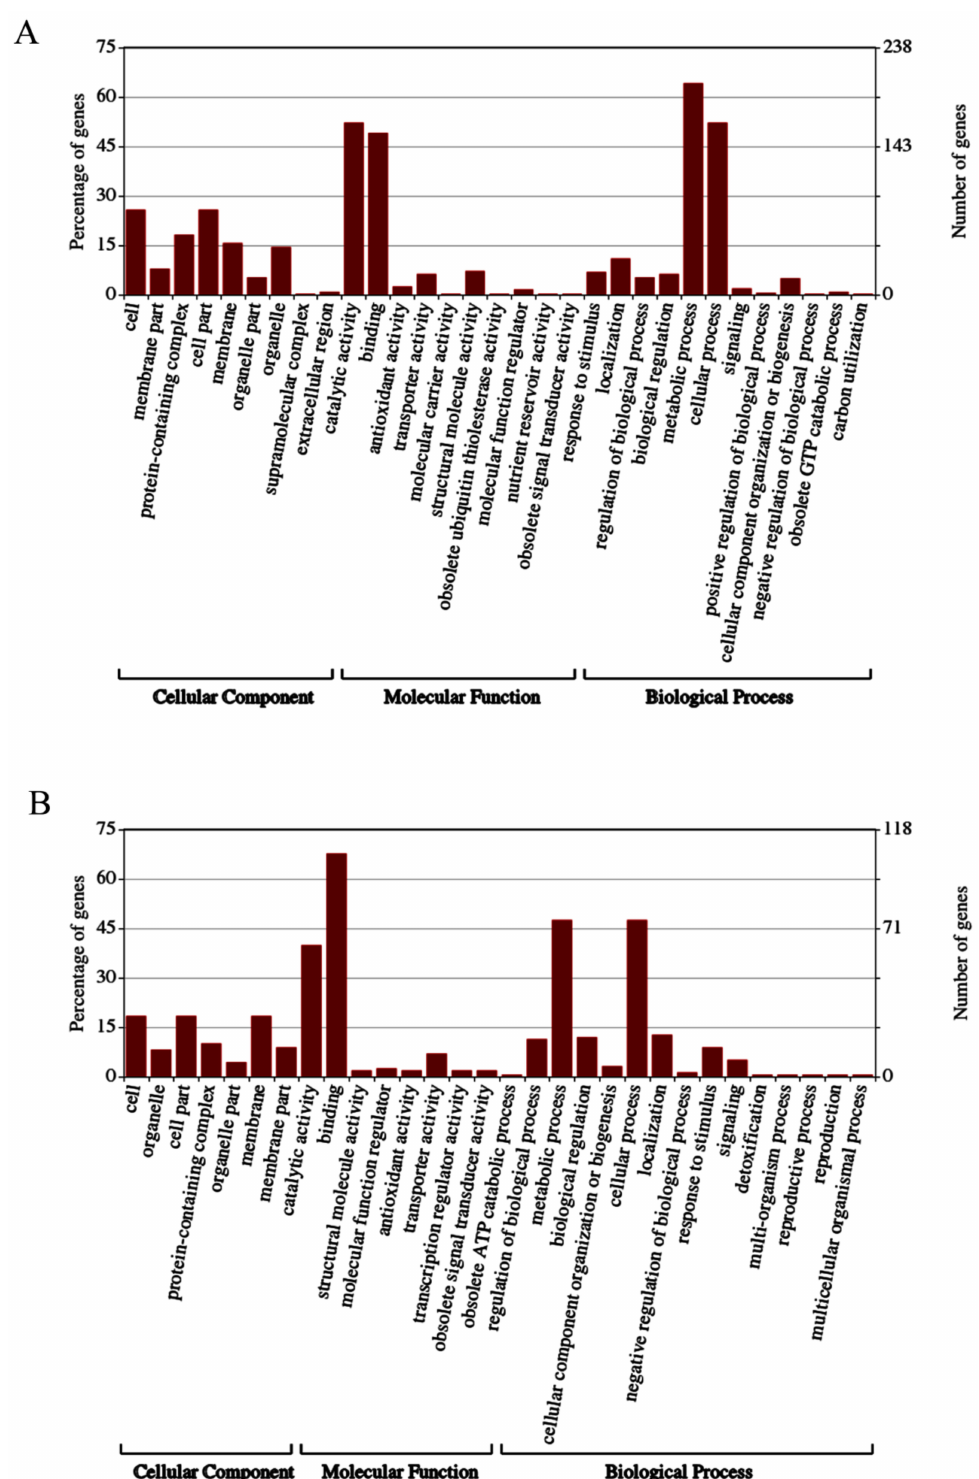
Figure 5. Gene ontology (GO) analysis of SEPs ( A ) and SCPL proteins ( B ). ( A ) The cellular components, biological processes, and molecular functions of differentially expressed proteins in samples; ( B ) The cellular components, biological processes, and molecular functions of differentially expressed phosphoproteins in